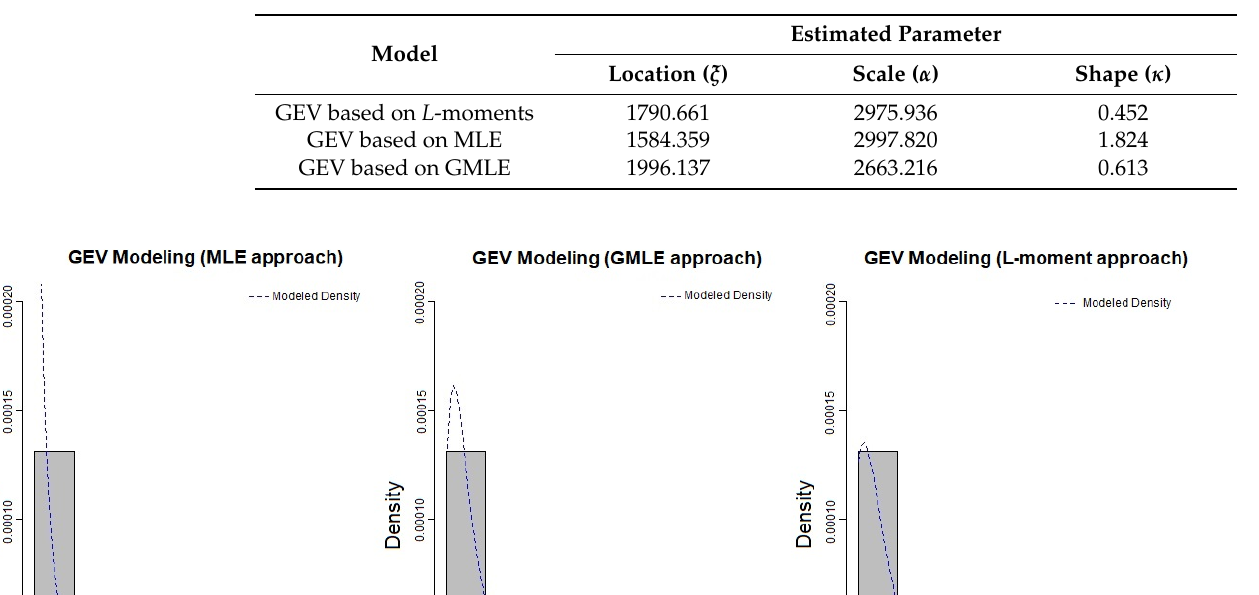
Table 3. Comparison of the results of parameter estimation for the fitted GEV model.